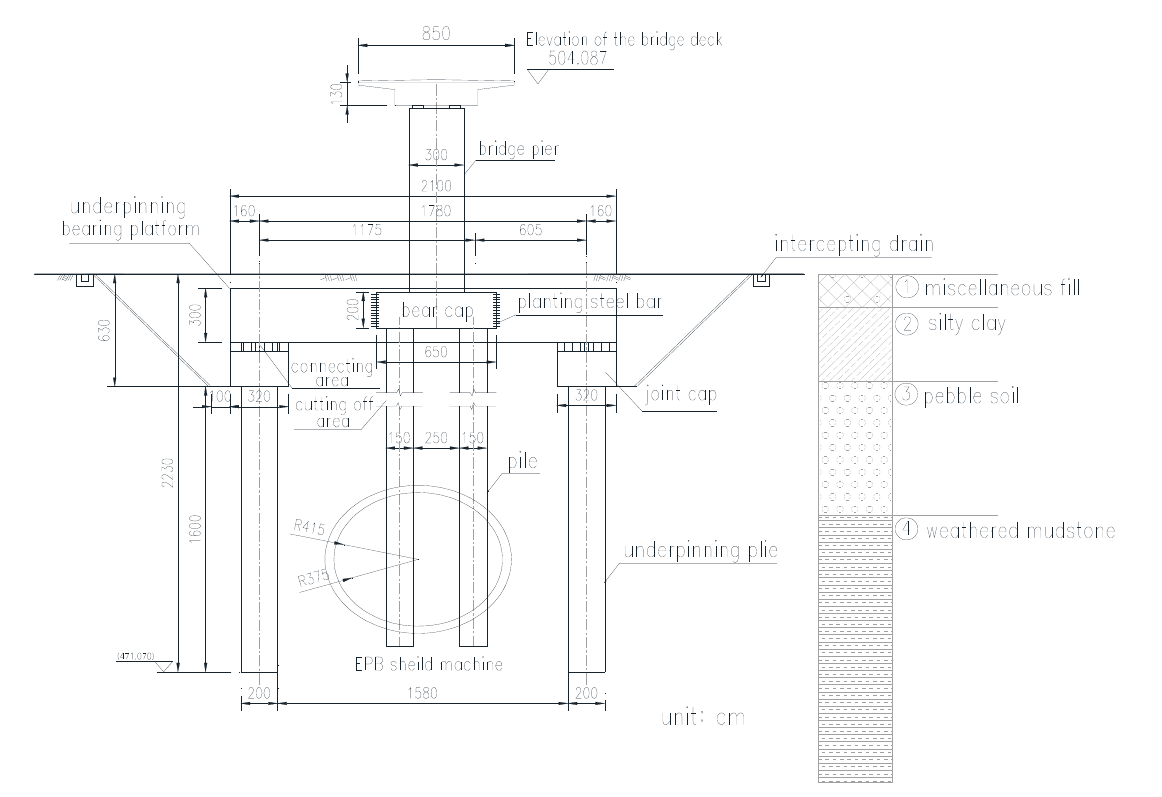
Figure 1. Elevation view of tunnel crossing viaduct foundation piles.